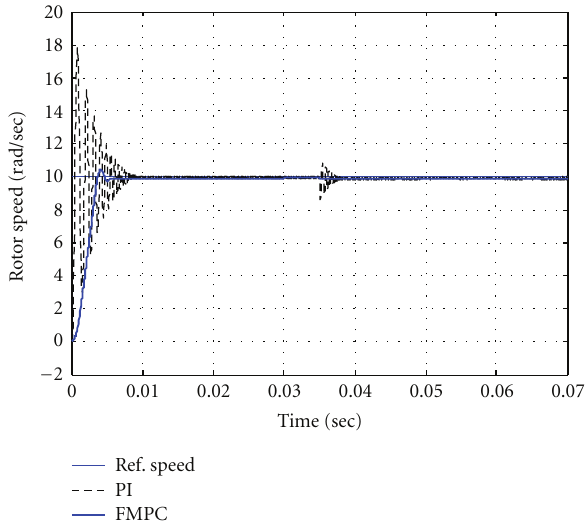
Figure 8: Low speed response at variable load based on proposed FMPC and PI controllers.